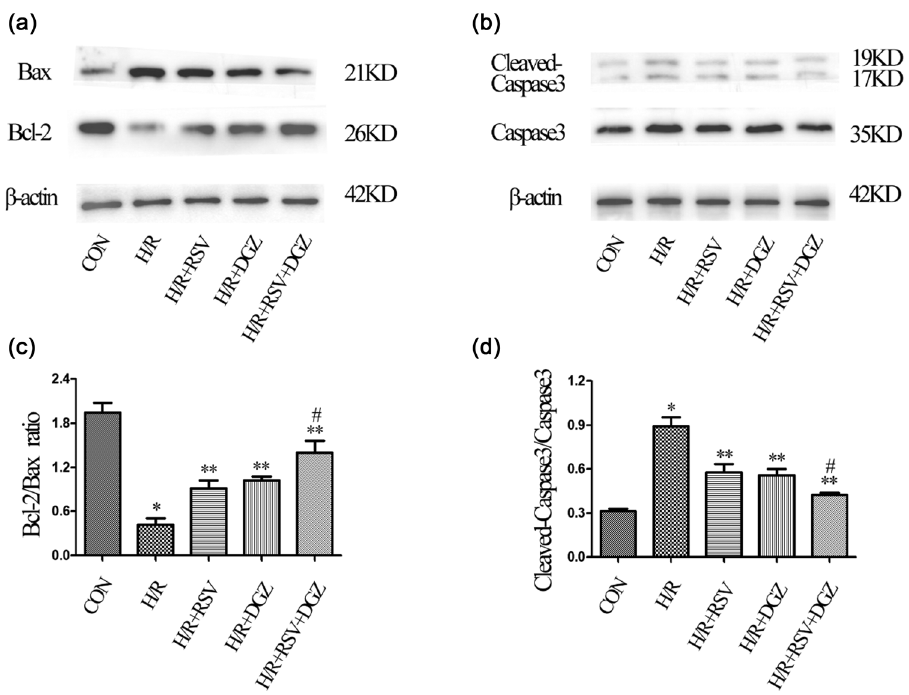
Figure 5: The expression levels of myocardial Bcl - 2, Bax, cleaved - caspase3, and caspase3, the quanti fi cation of the Bcl - 2/Bax ratio and cleaved - caspase3/caspase3 in the various groups ( mean ± SD, n = 3 ) . * p < 0.001 compared with CON; ** p < 0.05 compared with H/R; # p < 0.05 compared with H/R + RSV or H/R + DGZ. CON: control group; H/R: hypoxia/reoxygenation group; H/R + RSV: hypoxia/reox - ygenation + rosuvastatin group; H/R + DGZ: hypoxia/reoxygenation + dapagli fl ozin group; H/R + RSV + DGZ: hypoxia/reoxygenation + rosuvastatin + dapagli fl ozin group. Bcl - 2: B - cell lymphoma 2; Bax: Bcl - 2 - associated X protein.